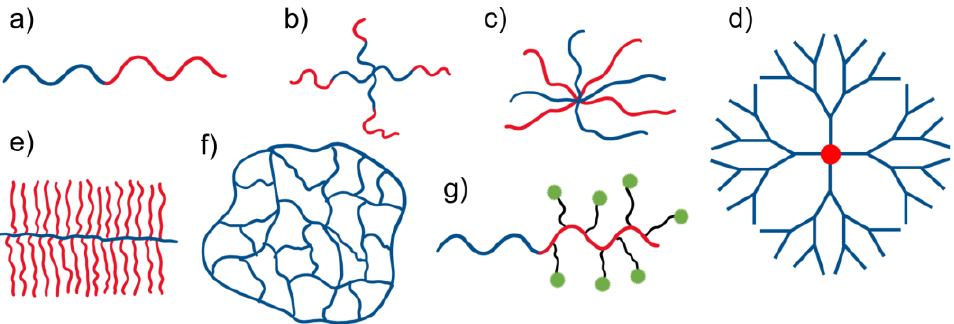
Figure 2. Representative molecular architectures synthesized via ATRP and applied in the formation of polymeric DDSs: ( a ) linear block copolymers, ( b ) regular star copolymers, ( c ) miktoarm star (co)polymers, ( d ) polymer brushes, ( e ) dendrimers, ( f ) nanogels, and ( g ) polymer – drug conjugate.